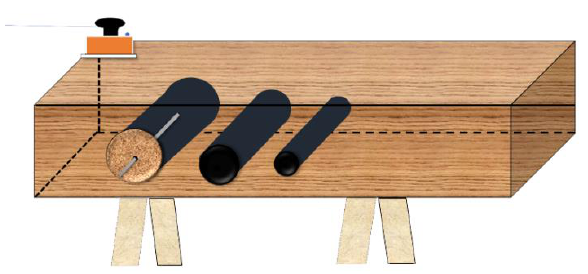
Figure 9. GPR scanning after inserting core-samples into the timber section.